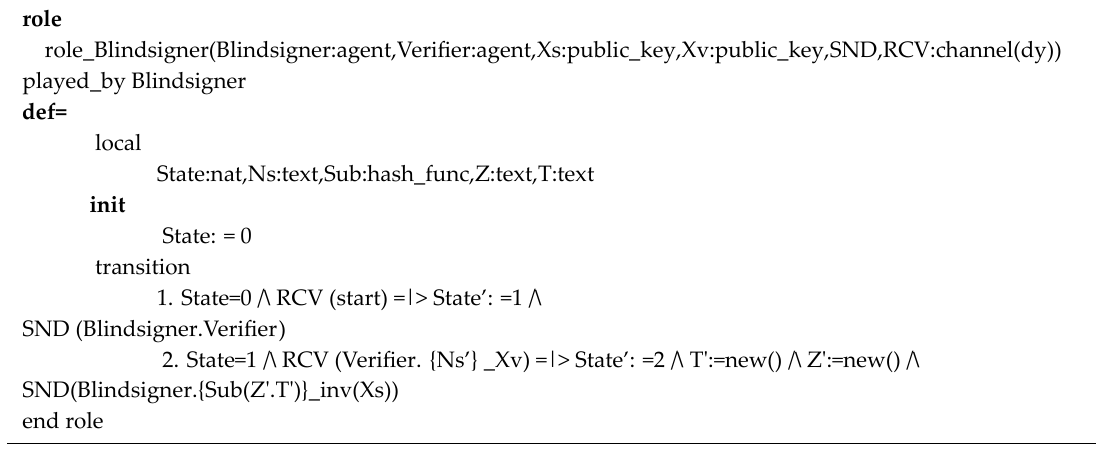
Algorithm A1 High-level protocol specification language (HLPSL) code for Signer role